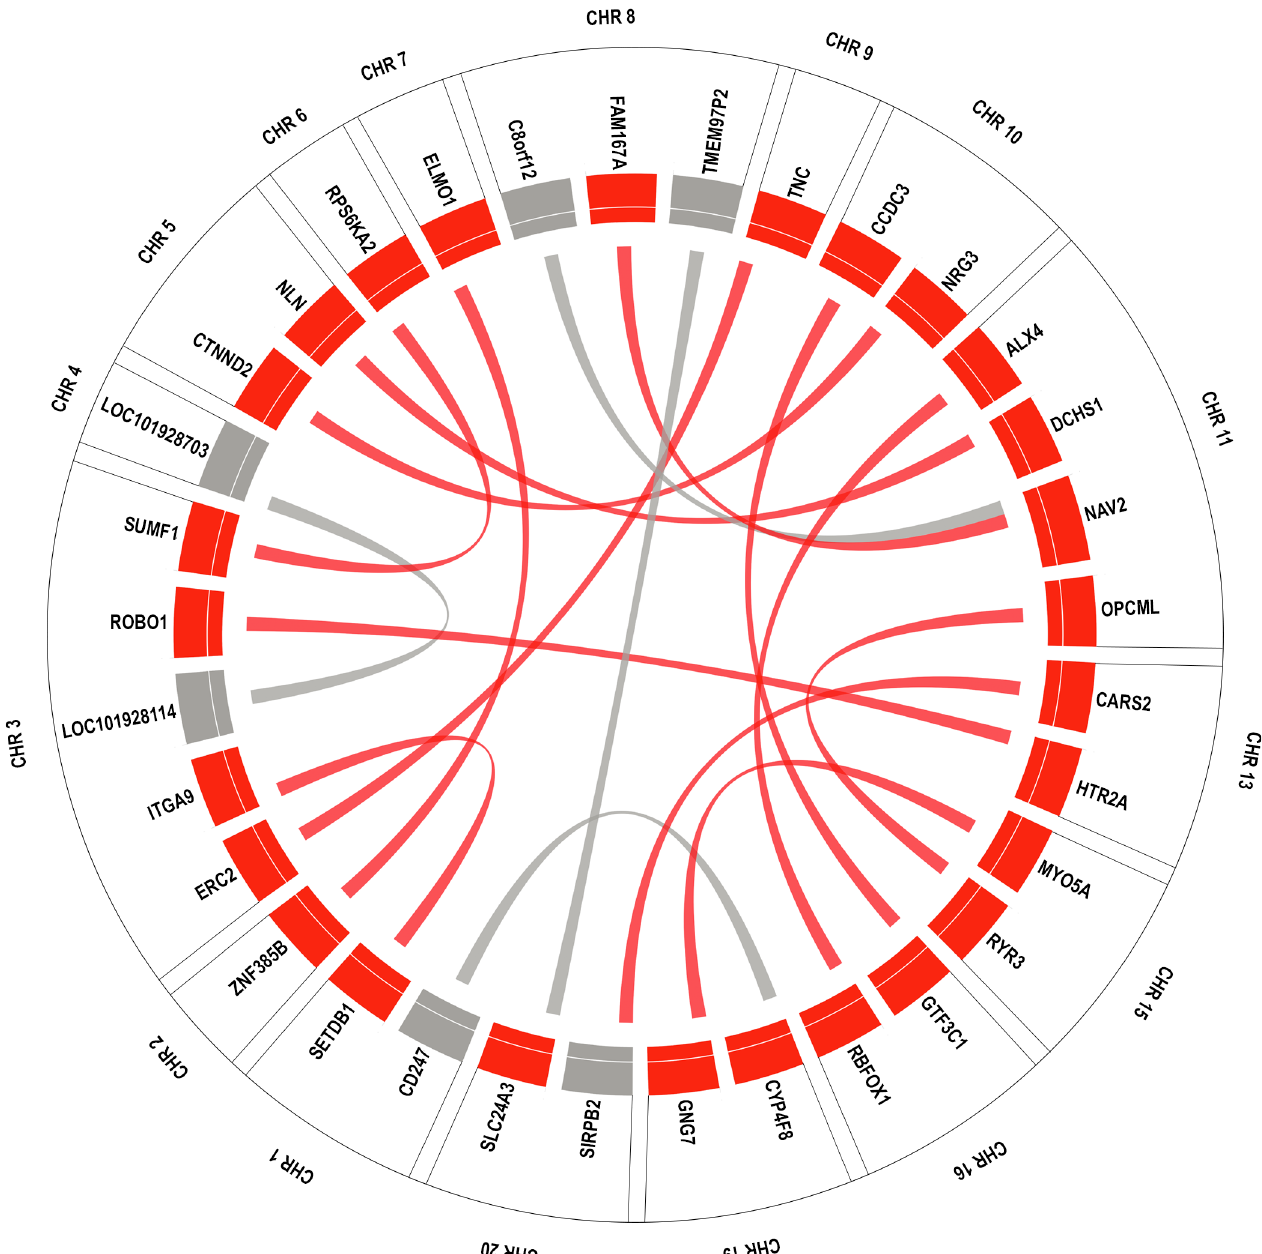
Fig 4. Circular plot representing only unique gene-gene interactions. Genes are colored as red if they are expressed in eye and as grey if not expressed in the eye. All genes are ordered by chromosome. Links between the genes represent gene-gene interactions that are